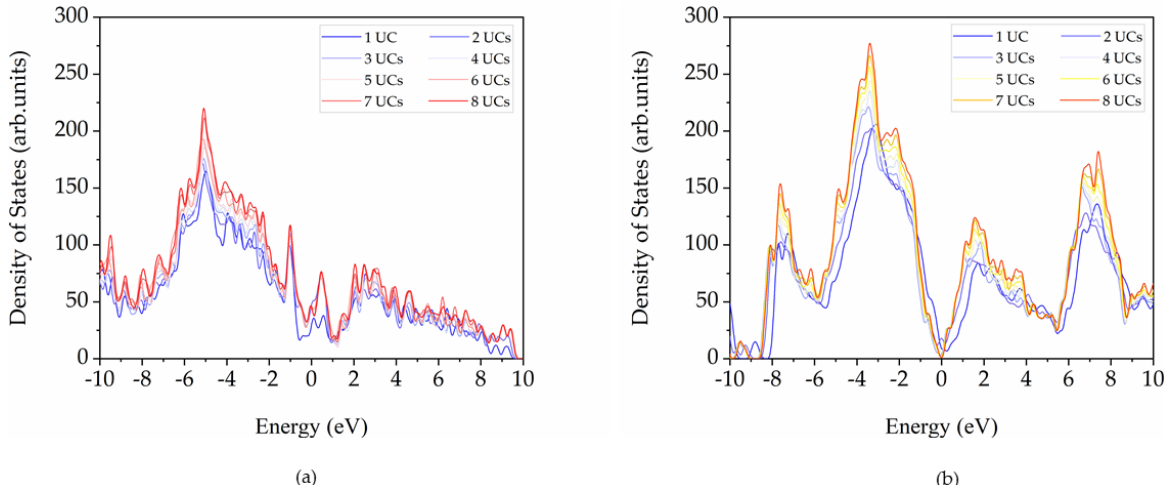
Figure 9. Density of states for 3D pillared ( a ) C and ( b ) SiC nanostructures as a function of the pillar lengths (Fermi level = 0 eV).